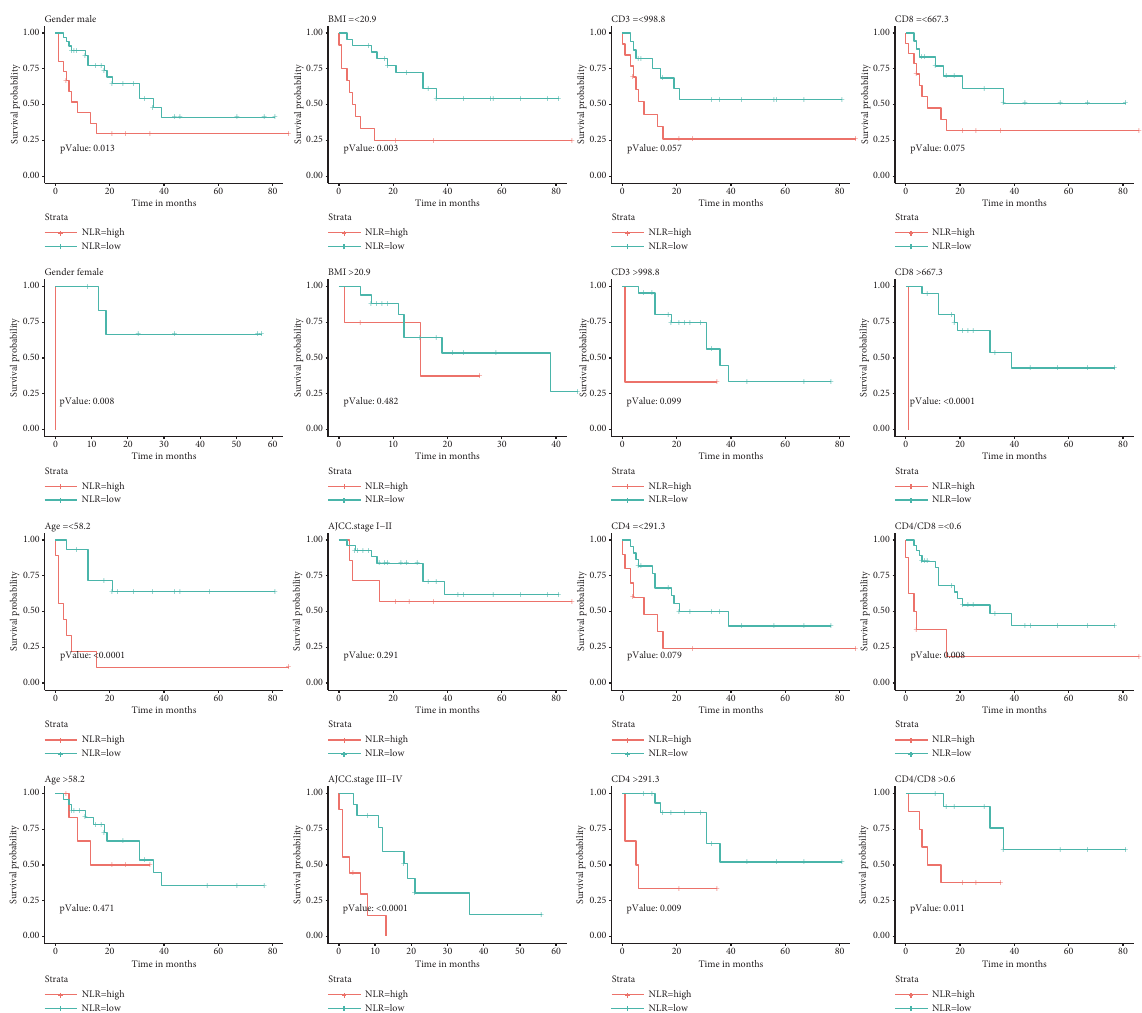
Figure 3: Analysis of PFS based on gender, age, BMI, AJCC stage, CD3+ T lymphocytes counts, CD4+ T lymphocytes counts, CD8+ T lymphocytes counts, and CD4/CD8 ratio in NLR